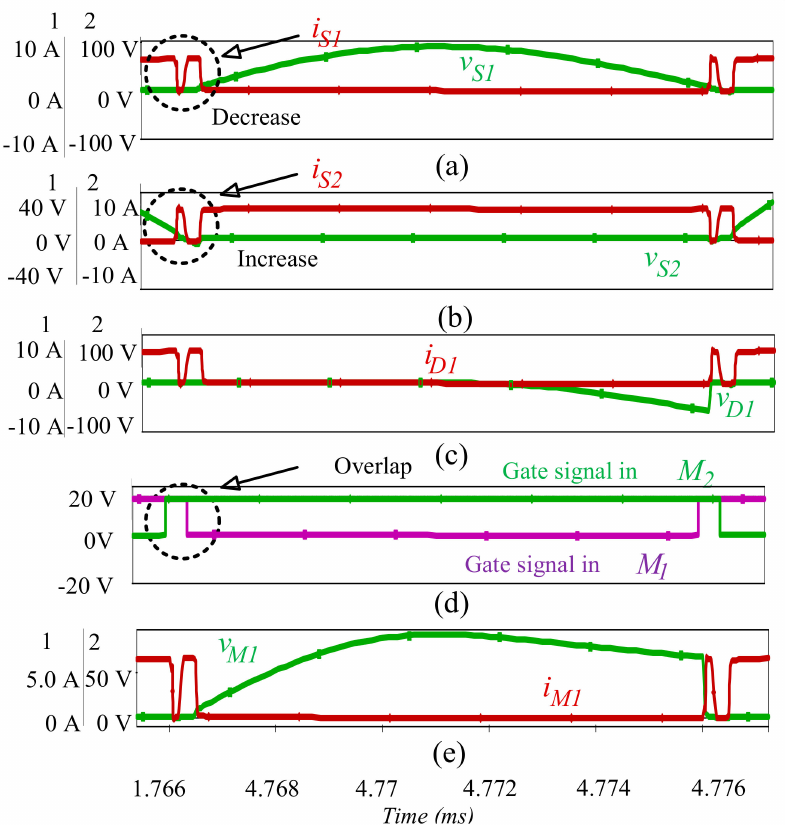
Figure 2. Simulation key waveforms: ( a ) voltage and current in switch S 1 ( v S 1 and i S 1 ), ( b ) voltage and current in switch S 2 ( v S 2 and i S 2 ), ( c ) voltage and current at the diode D 1 ( V D 1 and i D 1 ), ( d ) gate-signal in M 1 ( V GSM 1 ) and gate-signal in M 2 ( V GSM 2 ), ( e ) drain-source voltage and current at the MOSFET M 1 ( v M 1 and i M 1 ).